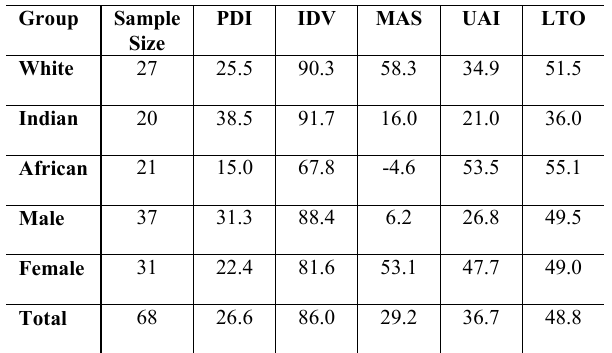
Table 2: Value dimension score by ethnic group